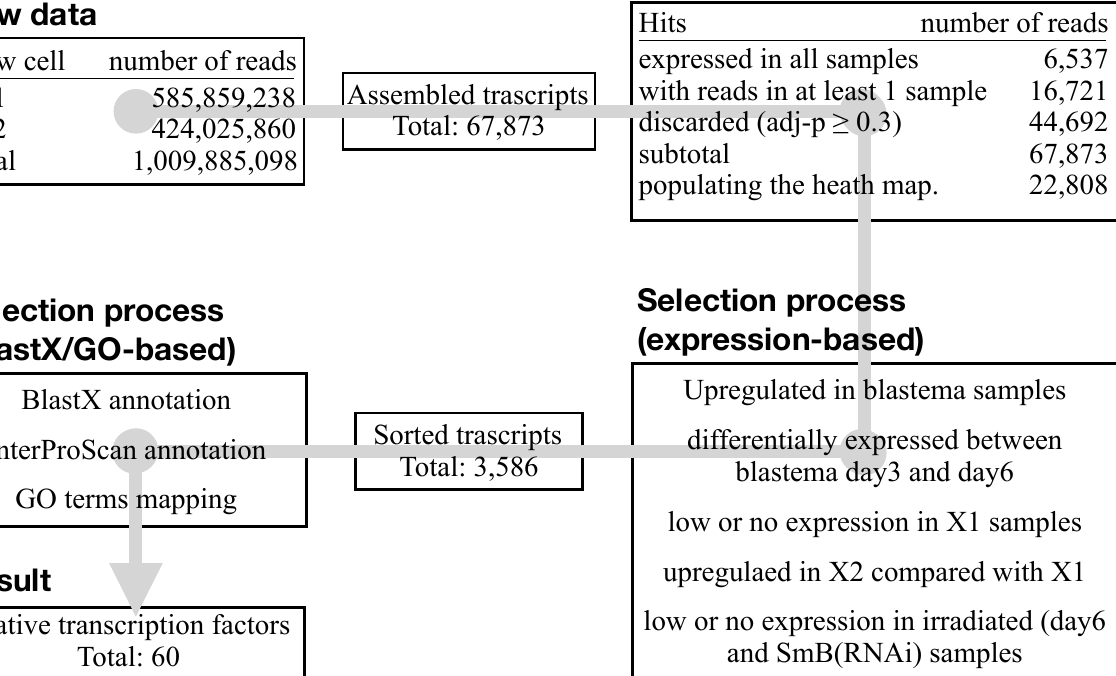
Figure 3. RNA-Seq analysis pipeline. Alongside the core analysis of the raw data (assembly, mapping, annotation), the complete pipeline consisted also of data sorting. Putative transcription factors active in the blastema were selected according to their relative expression level in the considered samples and their functional annotation (Blastx, InterProScan and GO). A total of 60 putative blastema transcription factors were eventually shortlisted.